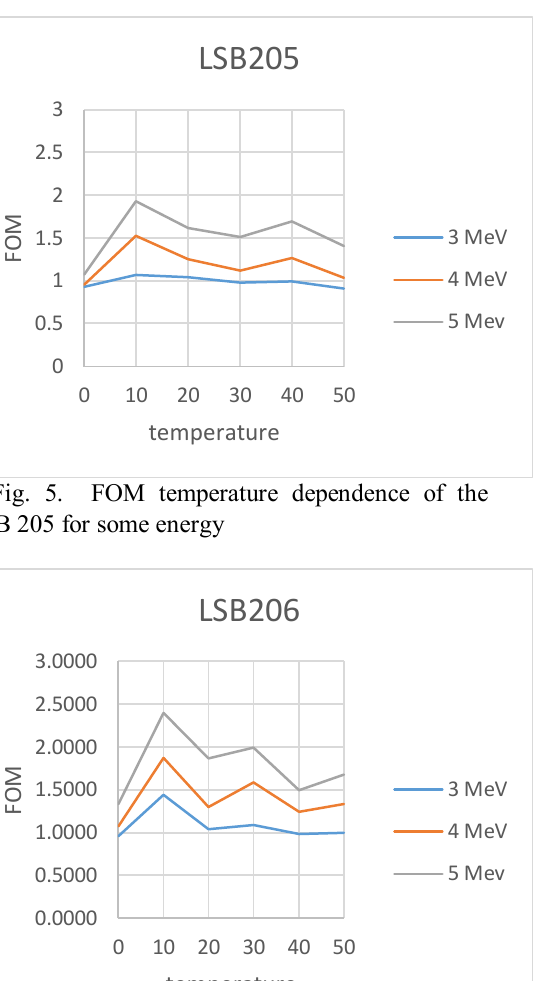
Fig. 4. FOM temperature dependencies of the NE213 scintillator